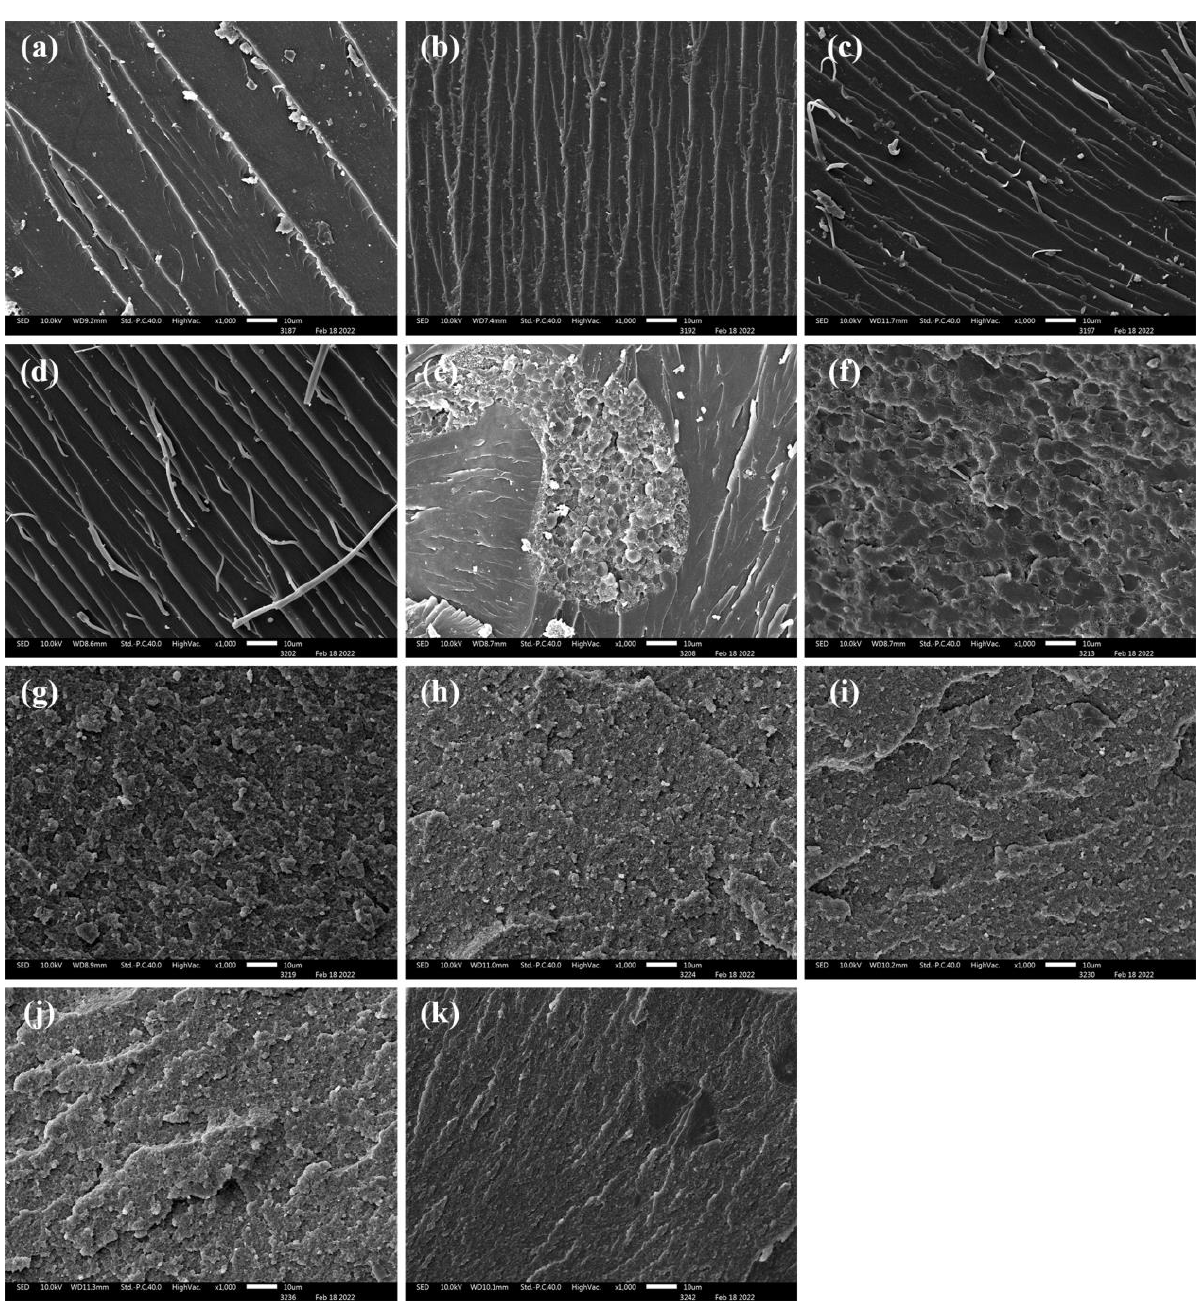
Figure 6. SEM images of different modified BMI adhesive systems: ( a ) 1A system; ( b ) 1B system; ( c ) 1C system; ( d ) 1D system; ( e ) 2A system; ( f ) 2B system; ( g ) 2C system; ( h ) 2D system; ( i ) 3A system; ( j ) 3B system; ( k ) 3C system.